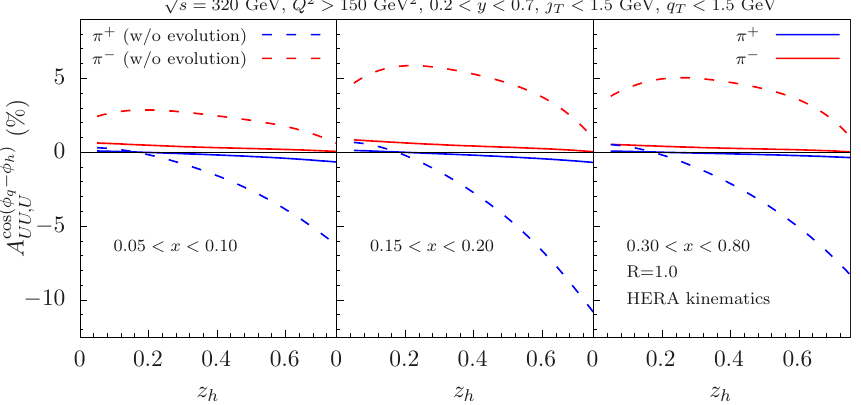
ˆ φ h ) Figure 4 . Numerical results of A cos( φ q − as a function of hadron momentum fraction z h for un- UU,U polarized π ± in jet production with electron in unpolarized ep collision predicted for HERA using three different bins of x : [0 . 05 , 0 . 1] , [0 . 15 , 0 . 2] , and [0 . 3 , 0 . 8] . The solid (dashed) curves are the √ calculations with (without) TMD evolution. We apply the center-of-mass energy s = 320 GeV of HERA kinematics, jet radius R = 1 . 0 , Q 2 > 150 GeV 2 , inelasticity y in [0 . 2 , 0 . 7] with transverse mo- mentum imbalance q T and final hadron transverse momentum in jet are both smaller than 1 . 5 GeV.